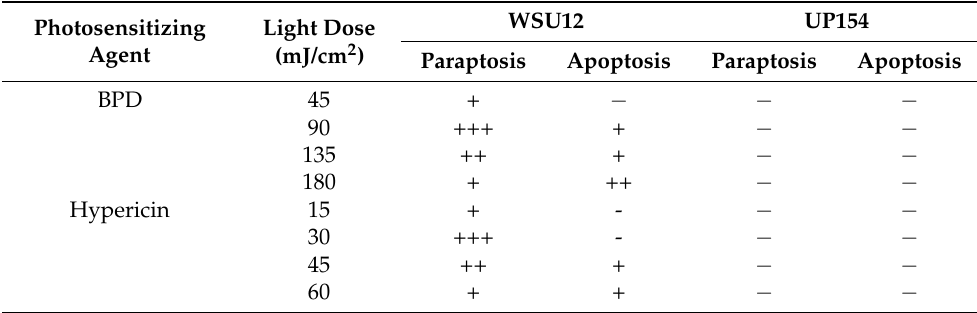
Table 1. BPD-photodynamic therapy (PDT)- and hypericin-PDT-induced cell death modes.